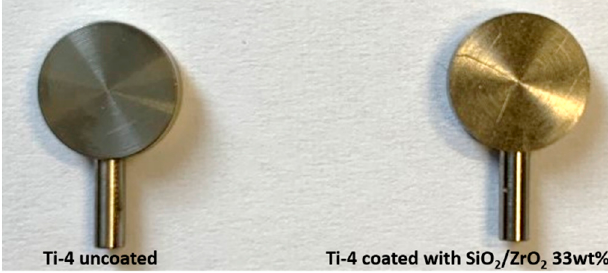
Figure 2. Representative images of the commercial Grade 4 titanium (Ti-4) disks: Untreated disk ( left ) and disk coated with SiO 2 /ZrO 2 (33 wt.%) ( right ).